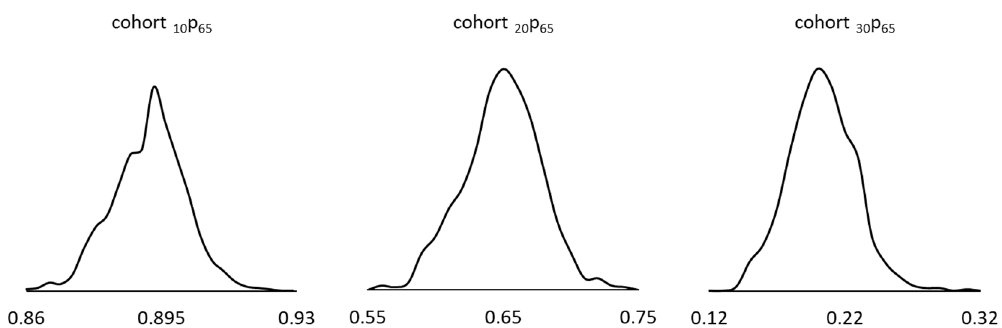
Figure 3. Simulated density functions of future survival probabilities of the cohort aged 65 (at the start of 2019) for 10, 20 and 30 years.